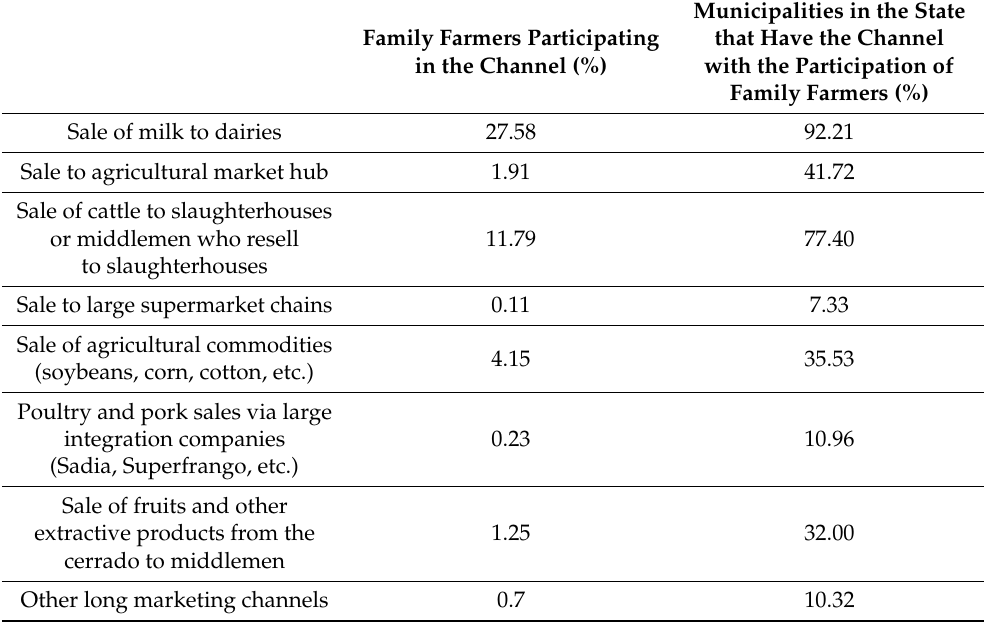
Table 2. Participation of family farmers and occurrence of long marketing channels in the municipali- ties of Goi á s.